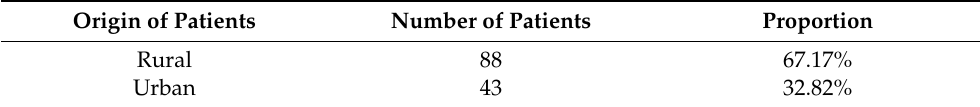
Table 7. Distribution of patients regarding their